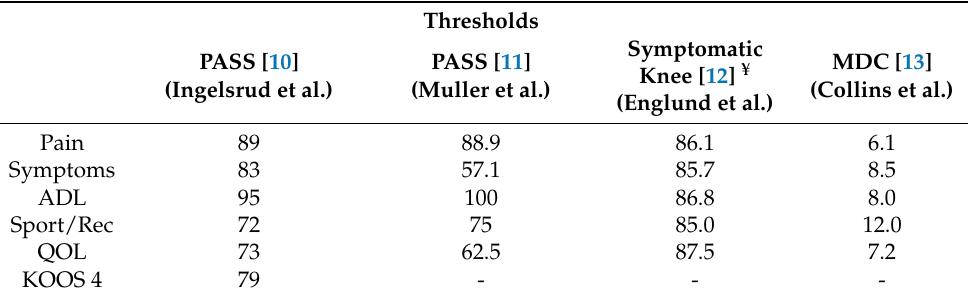
Table 1. Thresholds for The Knee injury and Osteoarthritis Outcome Score (KOOS) corresponding to the patient acceptable symptom state (PASS) and symptomatic knee for cross-sectional data, and minimal detectable change (MDC) for longitudinal